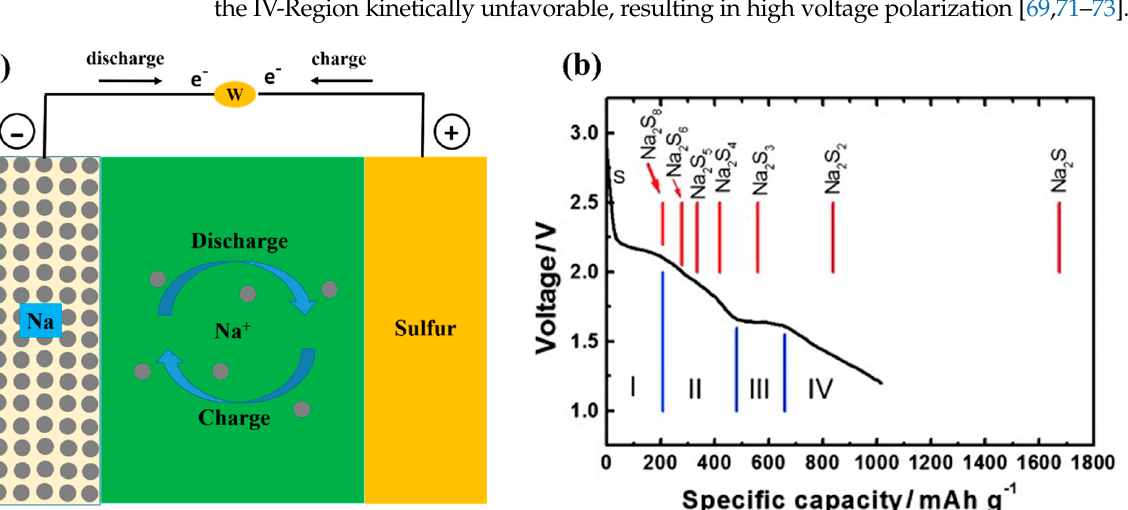
2014, ChemElectroChem 2014 , 1 , 1275–1280.)